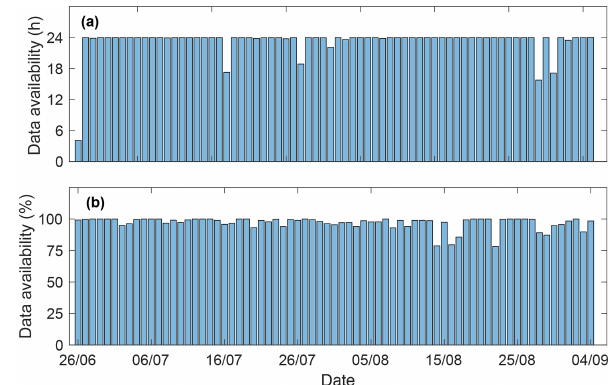
Figure 2. Lidar (a) and turbine (b) data availability for the duration of the campaign. Turbine power availability only corresponds to percentage of power measurements recorded for wind speeds above 2.5ms − 1 .